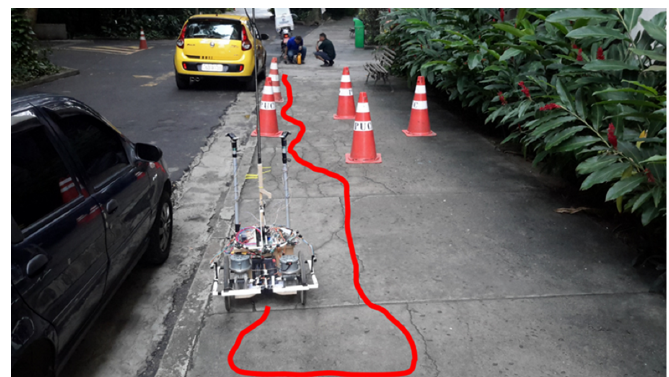
Figure 16. Starting position of route 1.